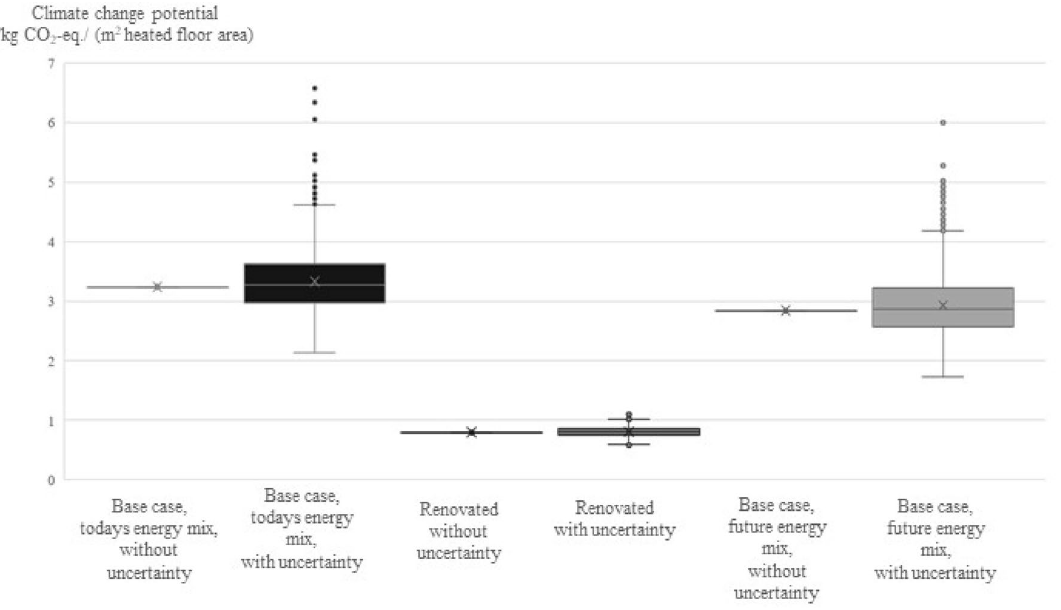
Fig. 8 Simulation results for the climate change potential due to the replacement of the south-facing walls on the ground and first floors. Results are shown with and without consideration of uncertainties in the input data and with two different scenarios for the energy